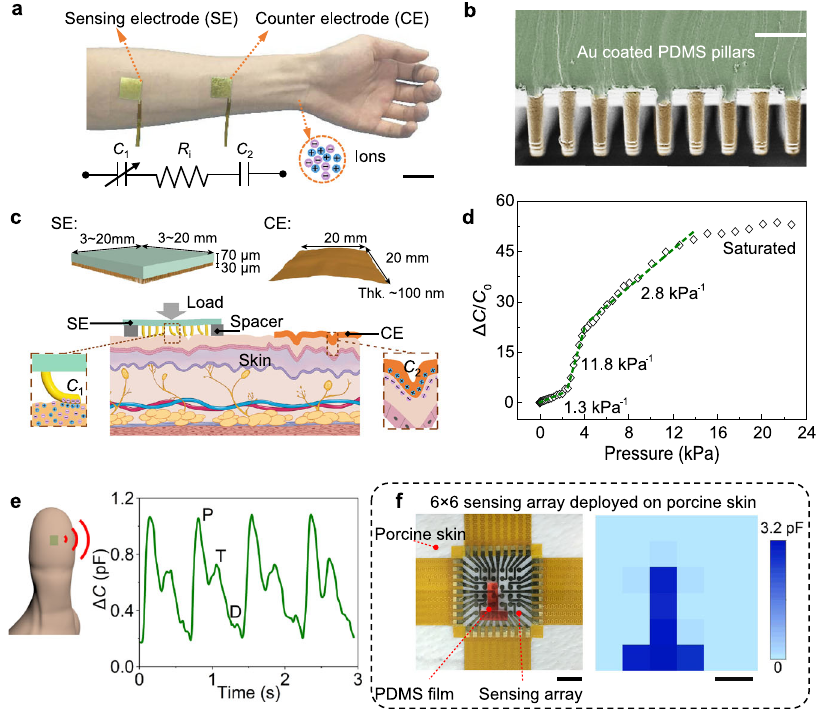
Fig. 1 Working mechanism and sensing performance of the SEMS. a Photograph of the SEMS with a sensing electrode (SE) and a counter electrode (CE) laminated on an arm, and a simpli fi ed equivalent circuit of the SEMS. Scale bar: 5 cm. b Scanning electron microscopy (SEM) image of the micropillared SE. Scale bar: 50 μ m. Similar result can be repeated for at least three times. c Exploded view and schematic illustration of the SEMS. The insets of the schematic show the skin-electrode interface upon loading. d Normalized change in capacitance as a function of applied pressure of the SEMS with a spacer measured at 10 4 Hz. e Typical fi ngertip pulse waveform measured using the SEMS. f A 6 × 6 SEMS pixel array that loads a T-shaped PDMS stamp (scale bar: 2 cm) and corresponding mapping of the signal (scale bar: 1